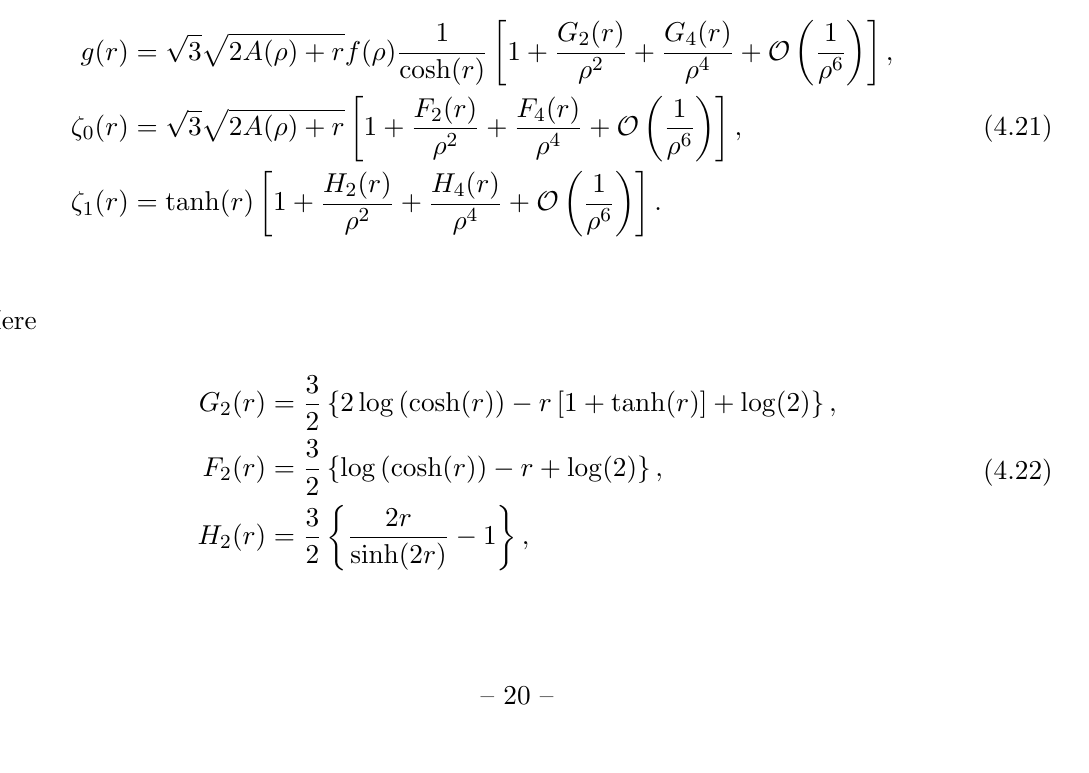
and required that the dependence on r is consistent with (3.6). We found the solution